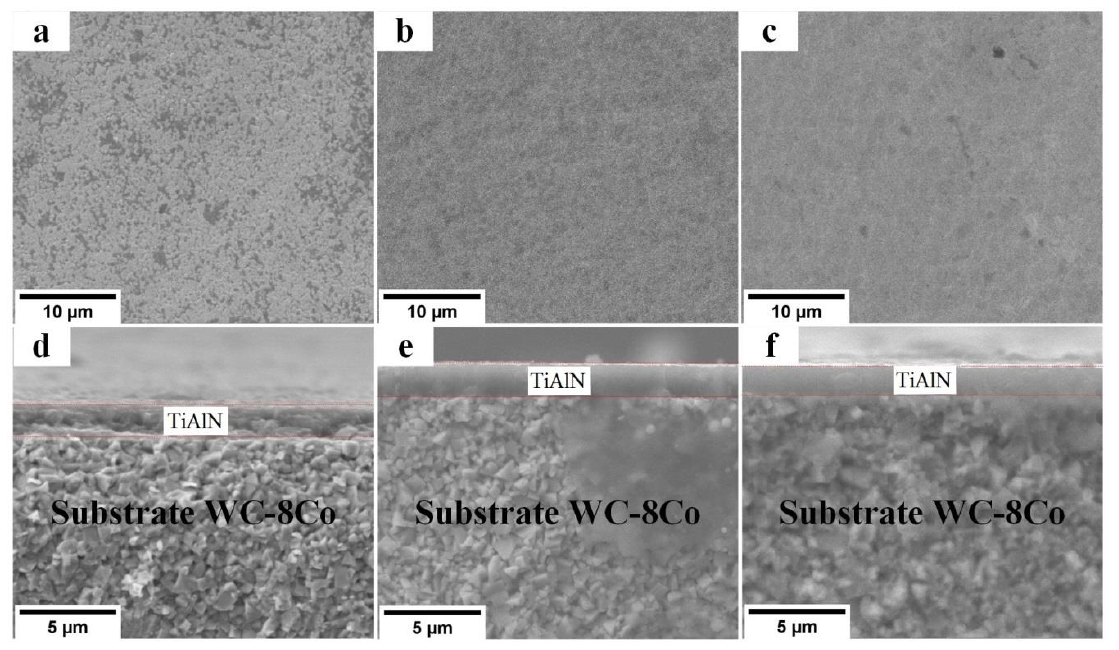
Figure 3. SEM images of the TiAlN coating surfaces and cross-sections deposited at the floating potential ( a , d ) and bias voltages of ( b , e ) − 50 V and ( c , f ) − 100 V. Al magnetron power: 30 W. Table 1. Elementary composition of TiAlN coatings deposited with an Al magnetron at 30 W of power and different bias voltages.